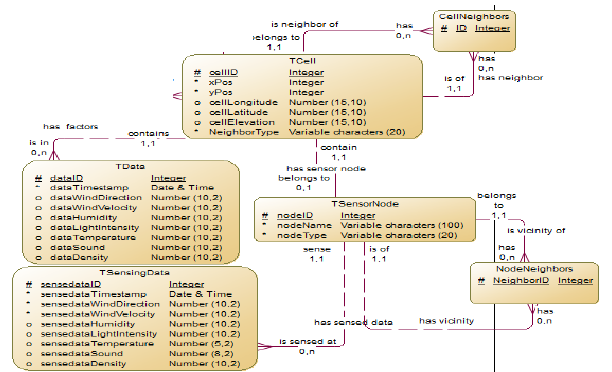
Figure 17. Data modelforBPH